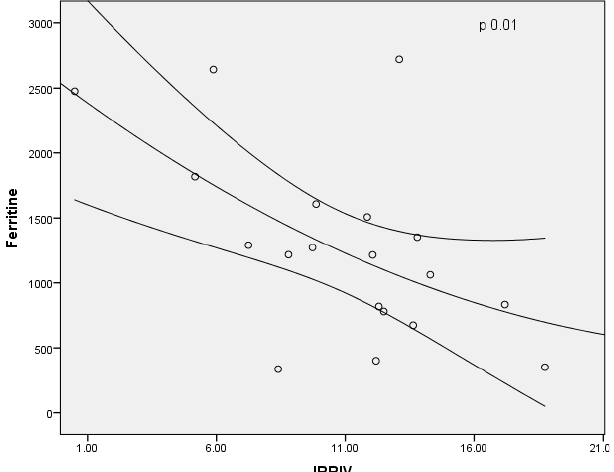
Figure 6. Inverse correlation between mean ferritin values and Delta RRI. Dot plot illustrating the correlation between mean ferritin values and Delta RRI (R = − 0.51, p = 0.03).